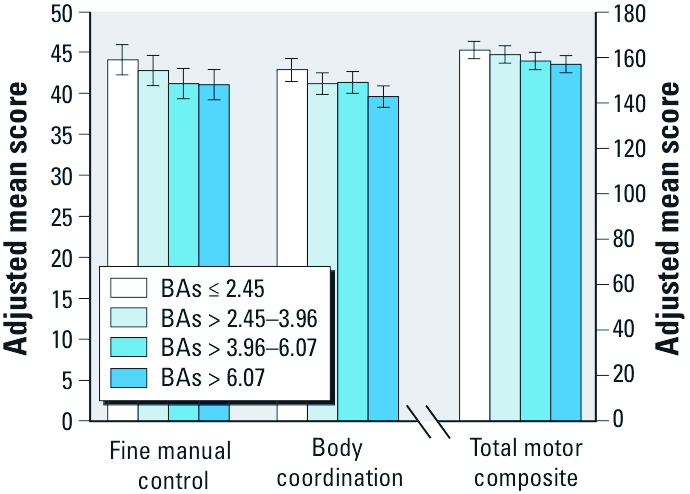
Covariate-adjusted mean scores by BAs quartiles for FMC, BC, and TMC scores. Models were adjusted for school attendance, head circumference, mother’s intelligence (WASI), plasma ferritin, BPb, BSe, and BMn. Significance levels: FMC (p = 0.07), BC (p < 0.05) and TMC (p = 0.1). Difference scales were used for adjusted mean scores for TMC.